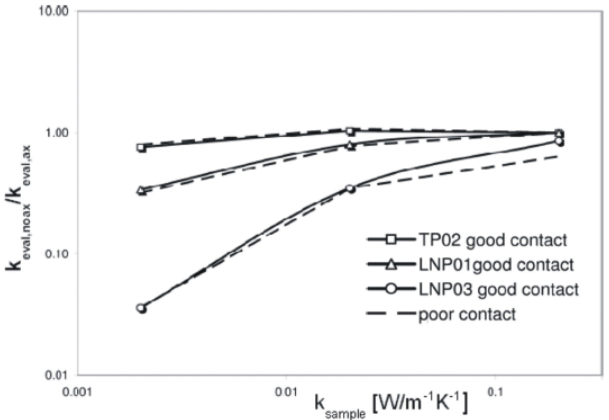
Fig. 20. Ratio of the conductivities determined from the measure- ment curves, obtained for scenarios including and not including ax- ial heat flow, versus the preset sample conductivity. The continuous lines stand for good contact between sensor and sample and dashed lines for poor